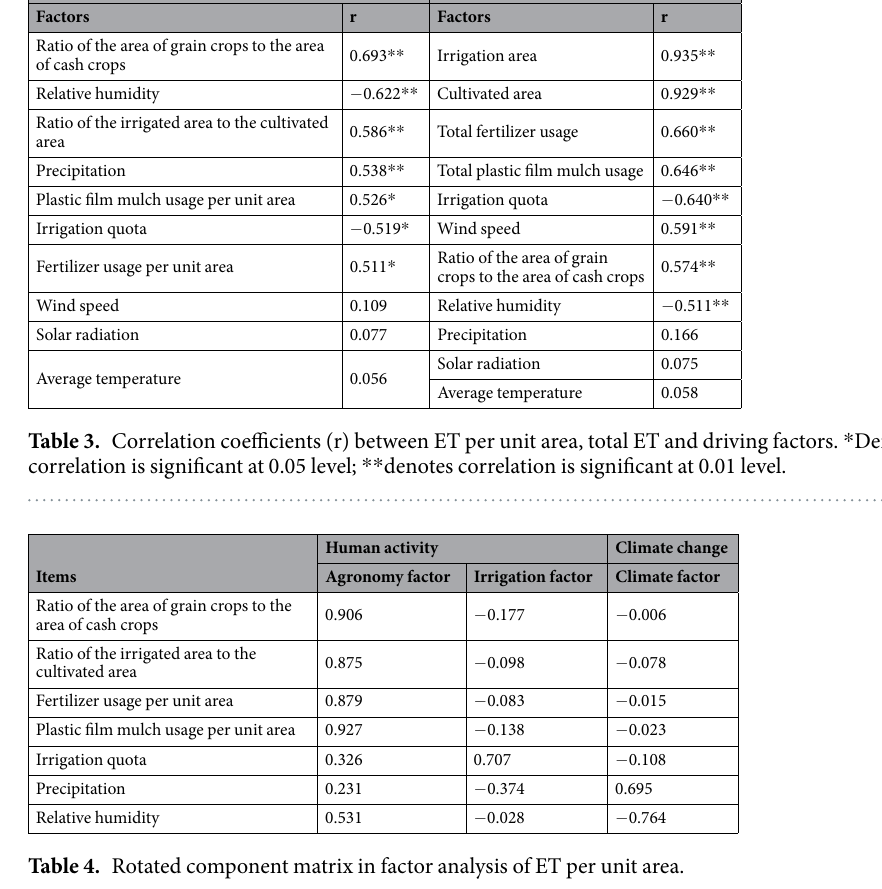
Table 4. Rotated component matrix in factor analysis of ET per unit area.